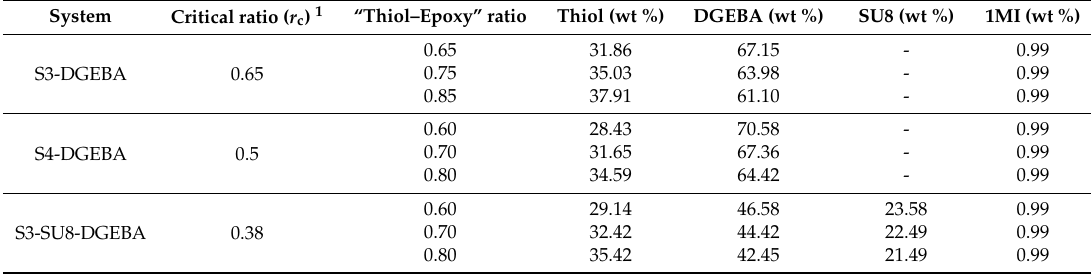
Table 1. Composition of the different formulations of